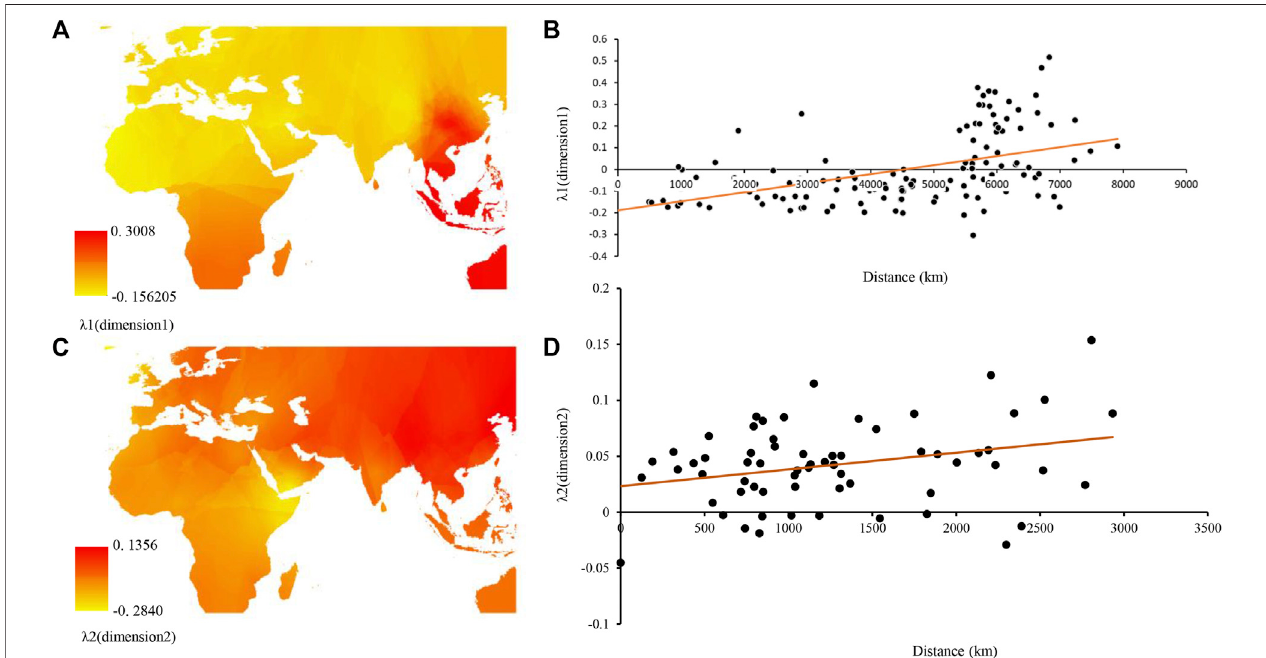
FIGURE 5 | Synthetic maps illustrating the geographic variation of eigenvalues ( λ ) for the fi rst two MDS dimensions ( λ 1 and λ 2) and regression of λ versus geographicdistance fromtheputative originalsiteofthecolonizationprocess. (A) Syntheticmap for λ 1, (B) syntheticmapfor λ 2, (C) regressionof λ 1versusgeographic distancesfromthedomesticationcenterofgoat( r 2 =0.22, p < 0.0001),and (D) regressionof λ 2versusgeographicdistancesfromaputative “ transportationhub ” ofthe Yunnan – Guizhou Plateau ( r 2 = 0.08, p =